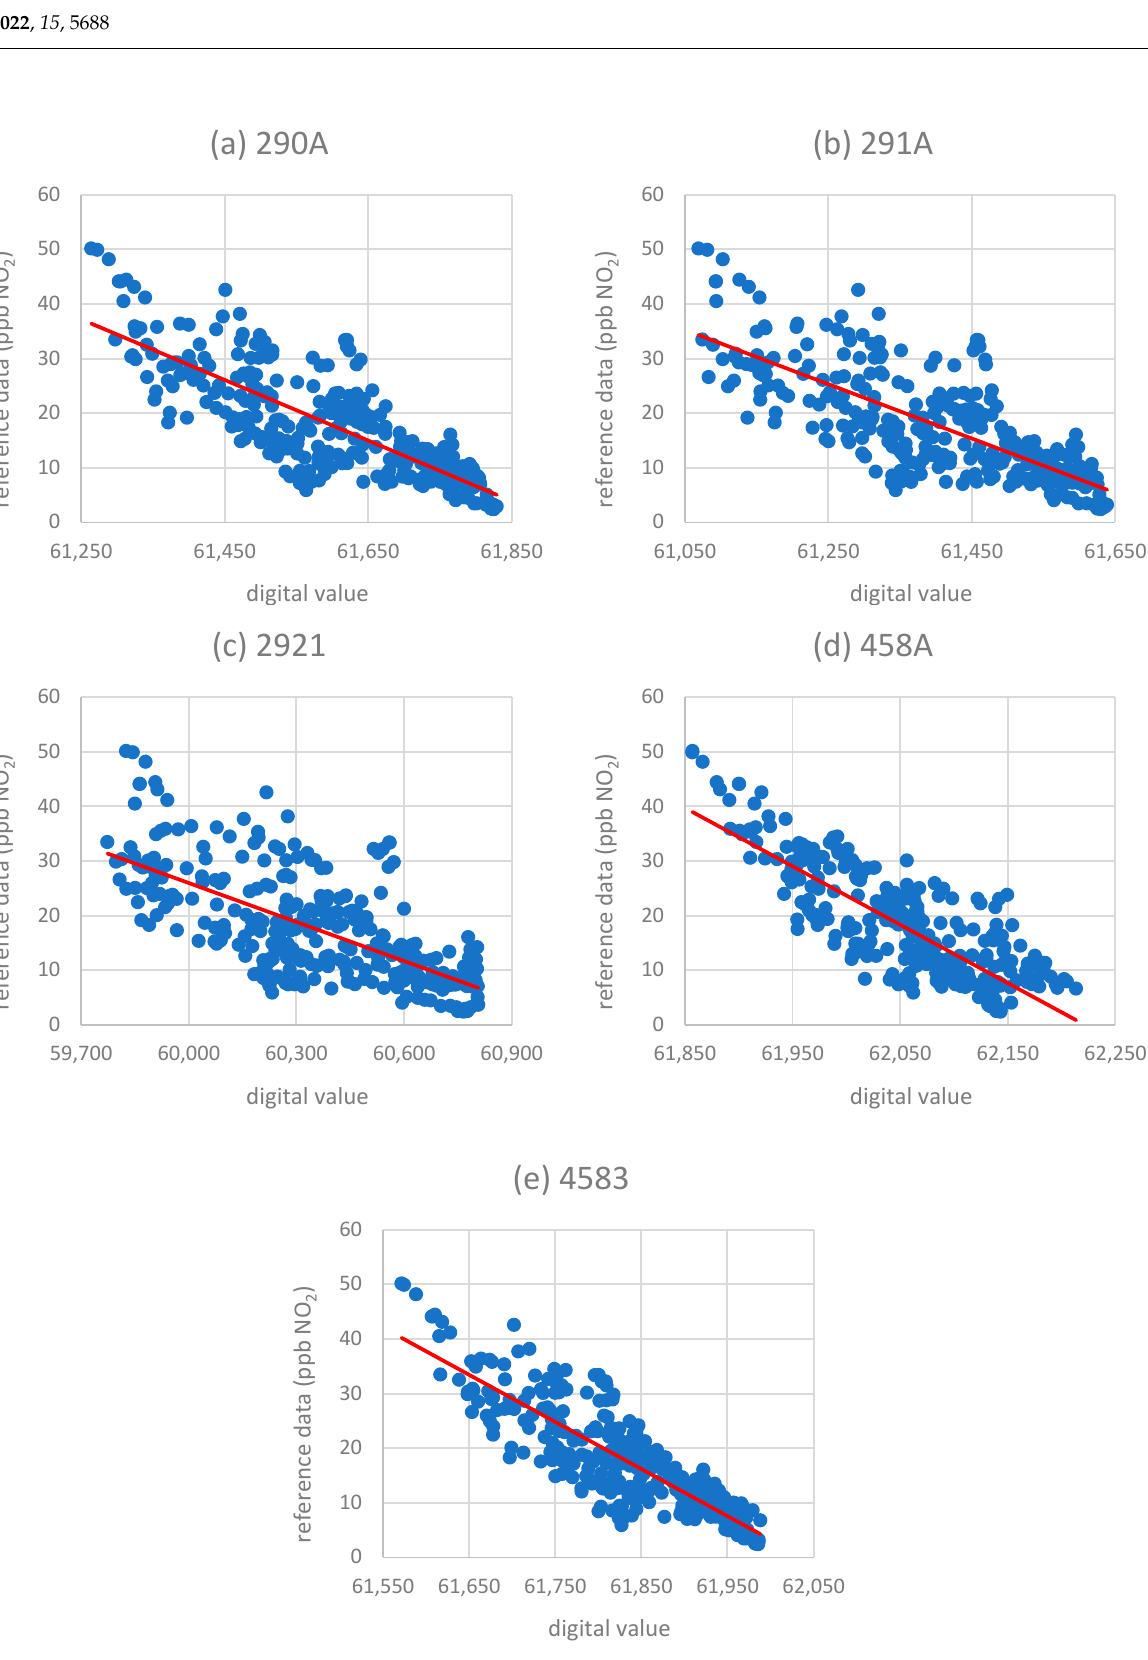
Figure 1. ( a – e ) Plotted data points (blue dots) and trend line (red) for the examined NO 2 sensors.